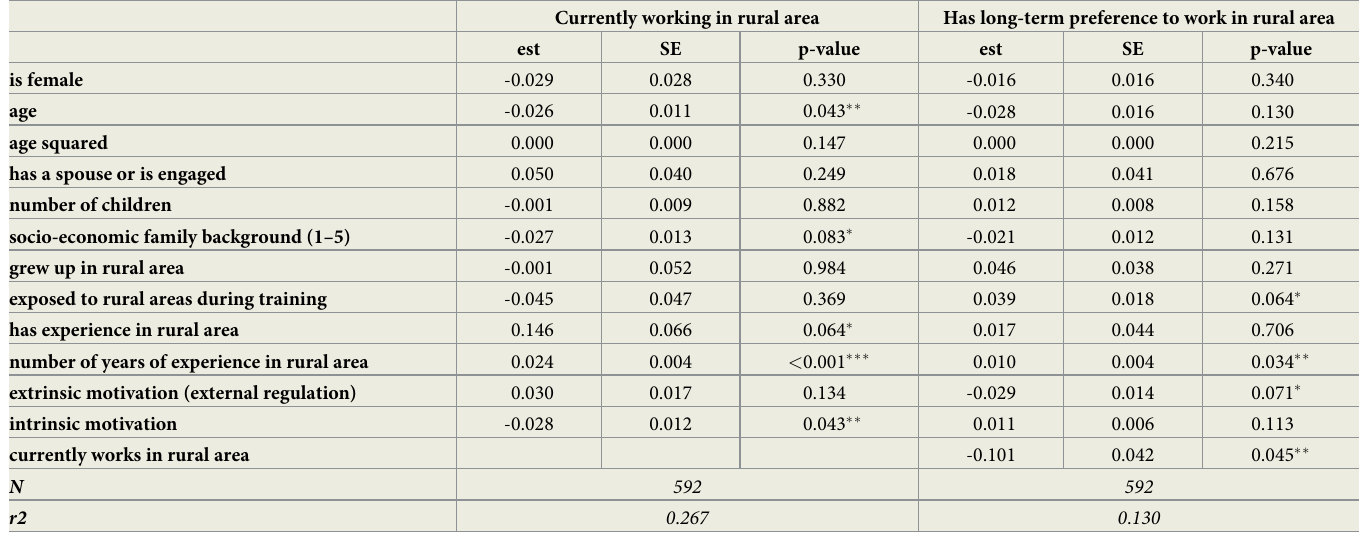
Table 5. Multiple regression model for predicting whether health worker currently works in and has long-term preference to work in rural health